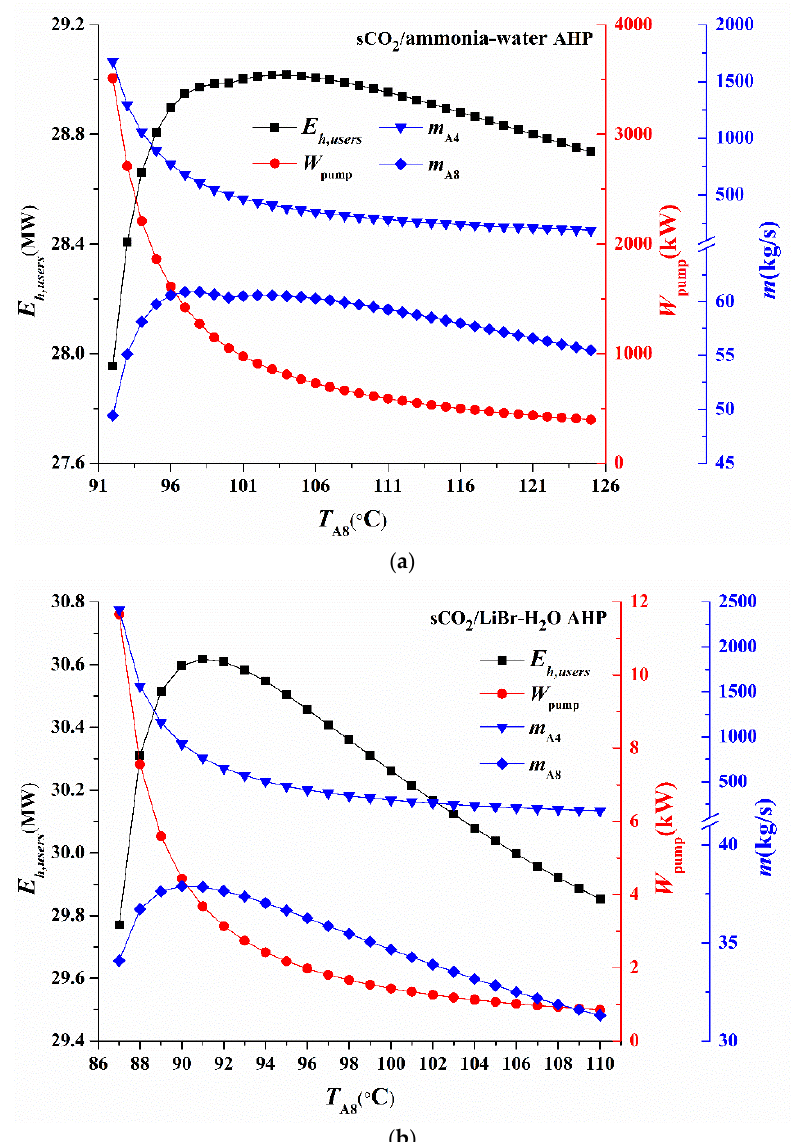
Figure 7. Variation trends of m A8 , m A4 , W pump, and E h,users with T A8 : ( a ) a sCO 2 /ammonia-water AHP system; ( b ) a sCO 2 /LiBr-H 2 O AHP system.